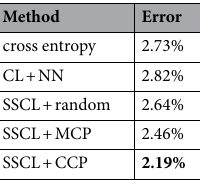
Table 2. Loss functions and class prototypes. Significant values are in bold.